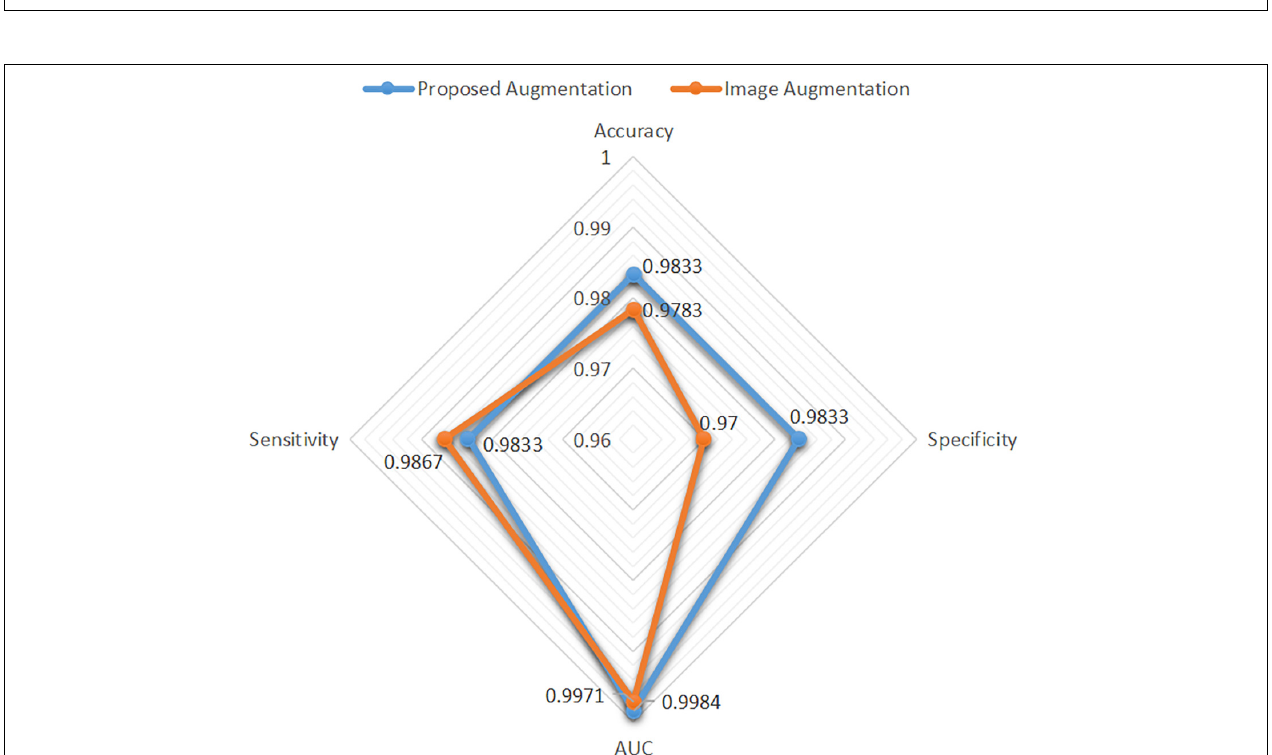
FIGURE 8 | Confusion matrix of the proposed network with different backbones: (A) ResNet-18, (B) ResNet-50, (C) VGG-11, (D) VGG-16, (E) DenseNet-121, and (F) DenseNet-161. The number on each sub-block represents the number of predictions, and the bars on the right of each block represent the heat value chart of the predicted numbers.